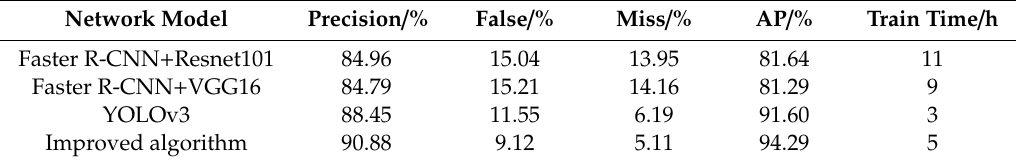
Table 3. Performance comparison of four models on the MyPlane dataset.